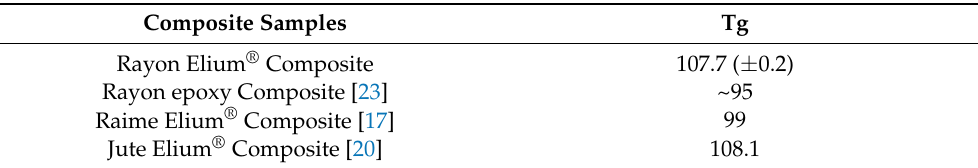
Table 7. Comparative Tg values of Elium ® and epoxy composite systems with rayon and NF